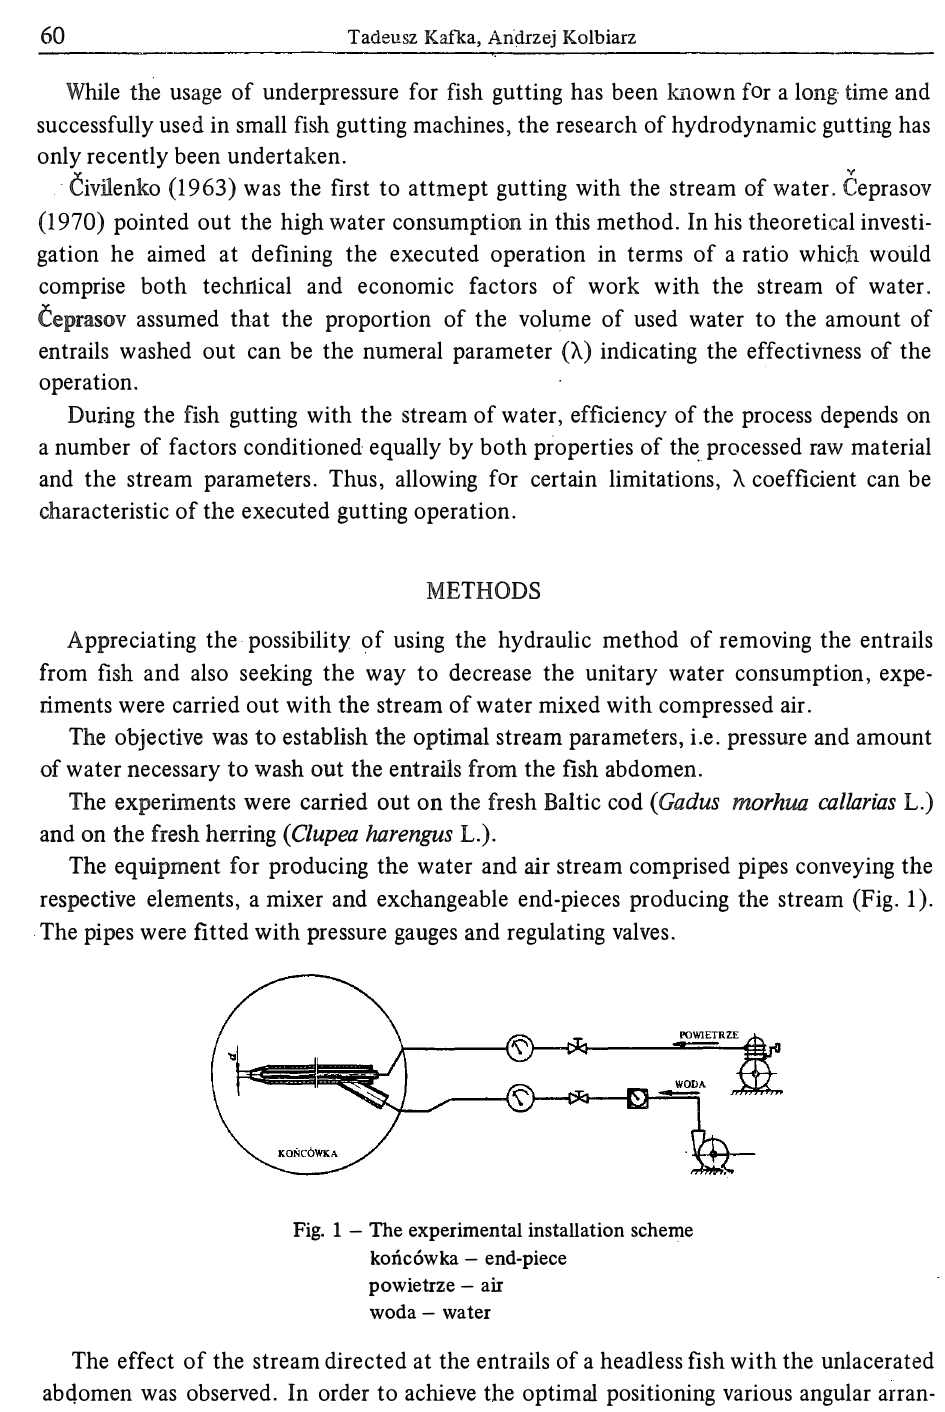
Fig. l -The experimental installation scheme konc6wka -end-piece powietrze -air woda